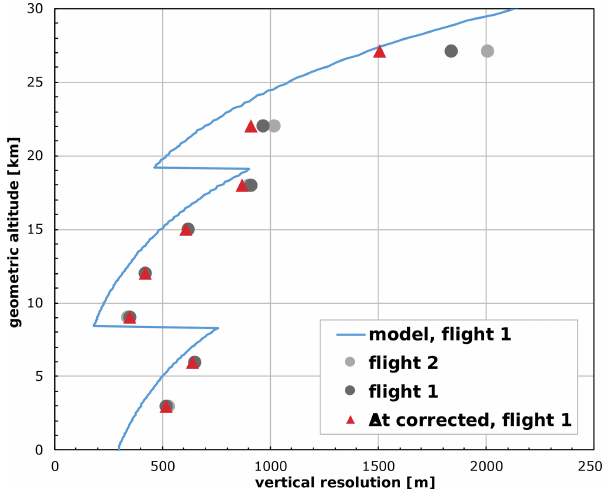
Figure 8. Modeled (blue line), uncorrected (flight 1: dark grey cir- cles, flight 2: light grey circles) and corrected (only flight 1: red triangles) vertical resolution of